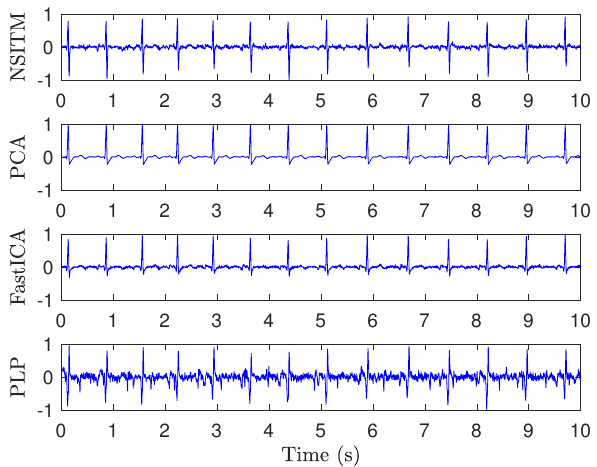
Figure 8. Extracted MECG signals from ECG signals in Figure 6, using NSITM, PCA, FastICA, and PLP, assuming M = 7 (five abdominal signals x 1 ( n ) – x 5 ( n ) and two thorax signals x 6 ( n ) – x 7 ( n ) . The y -axis labels refer to the names of the algorithms used for extracting the MECG signals. Data used are from the DAISY data